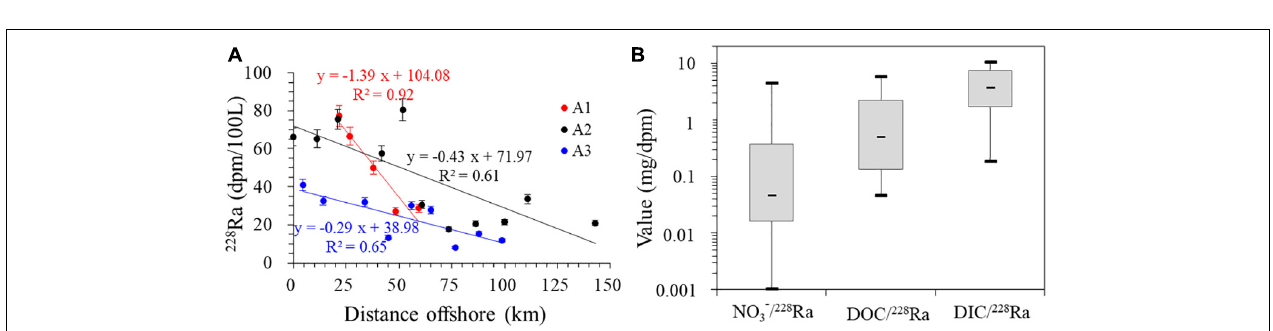
FIGURE 5 | Plots of panel (A) 224 Ra and (B) 223 Ra activity vs. distance offshore at three transects A1–A3; the dots and lines are the measured and modeled radium activities, respectively.